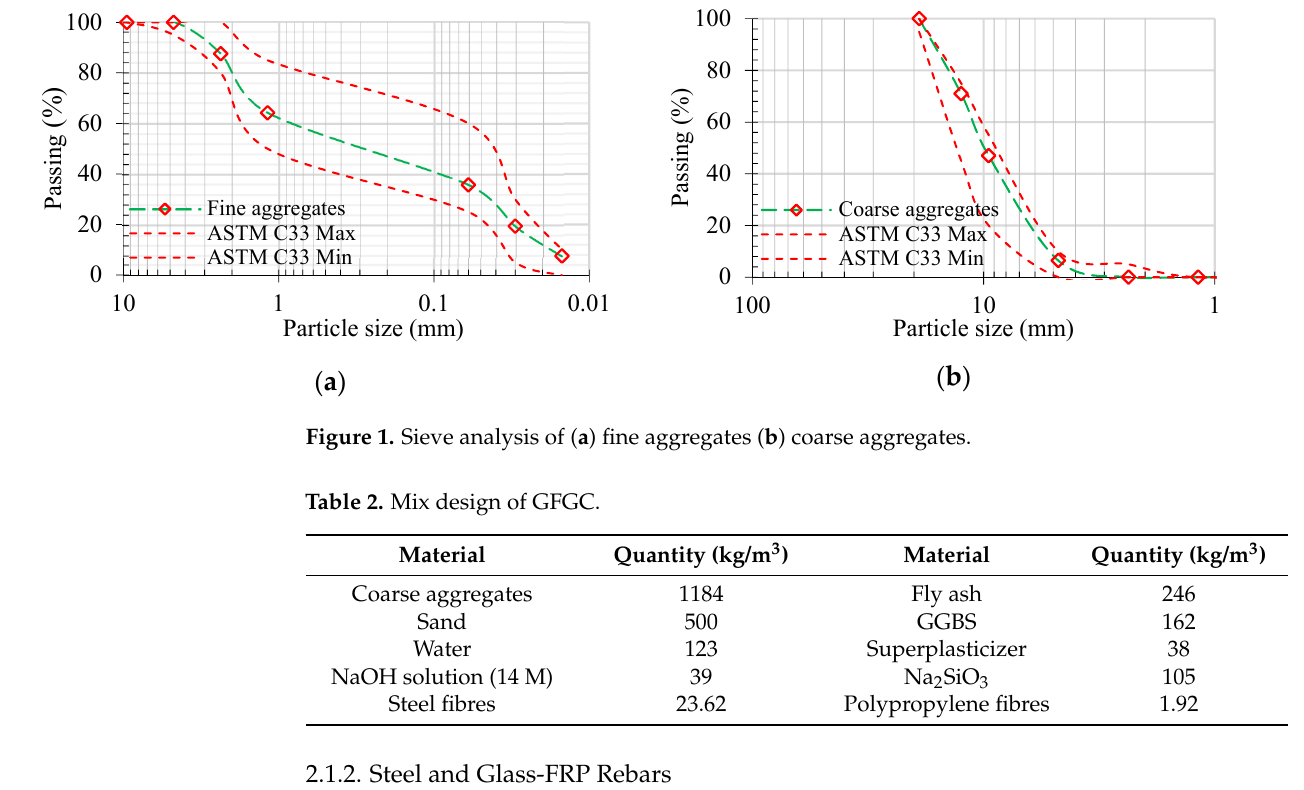
Table 3. Engineering parameters of steel and glass-FRP